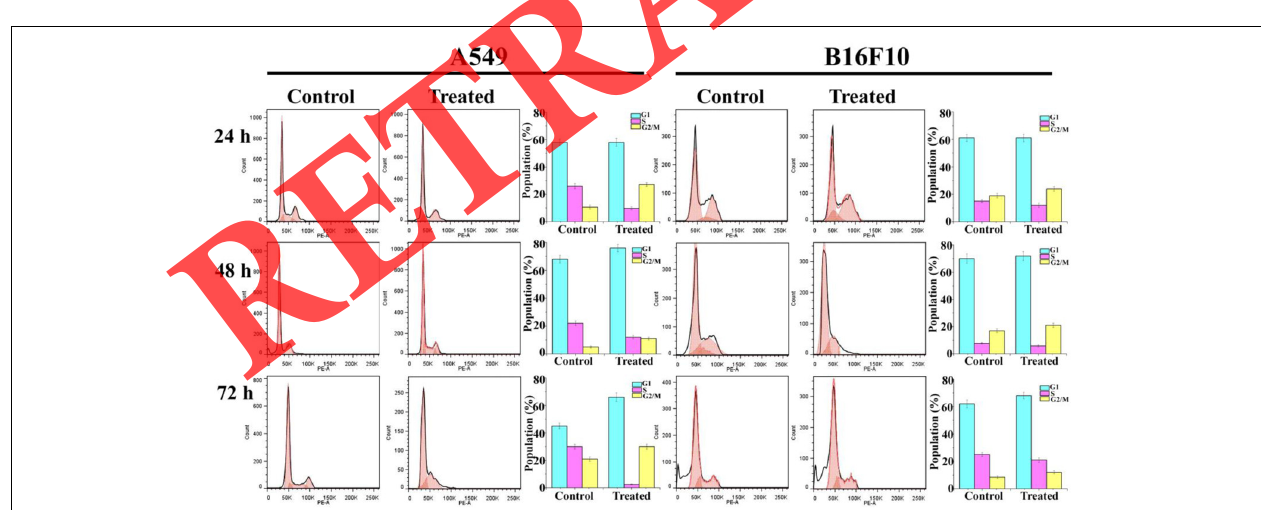
FIGURE 6 | Hoechst staining of A549 and B16F10 cells. Treatment with Pseudopyronine B resulted in apoptotic death.